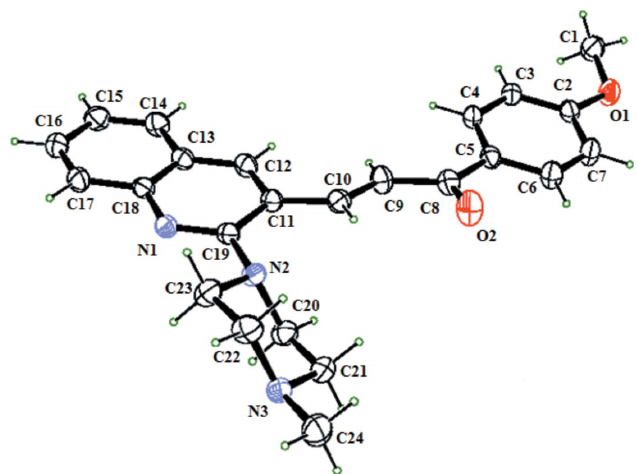
Figure 1 The molecular structure of the title compound. Displacement ellipsoids are drawn at the 40% probability level. H atoms are shown as small spheres of arbitrary radii.